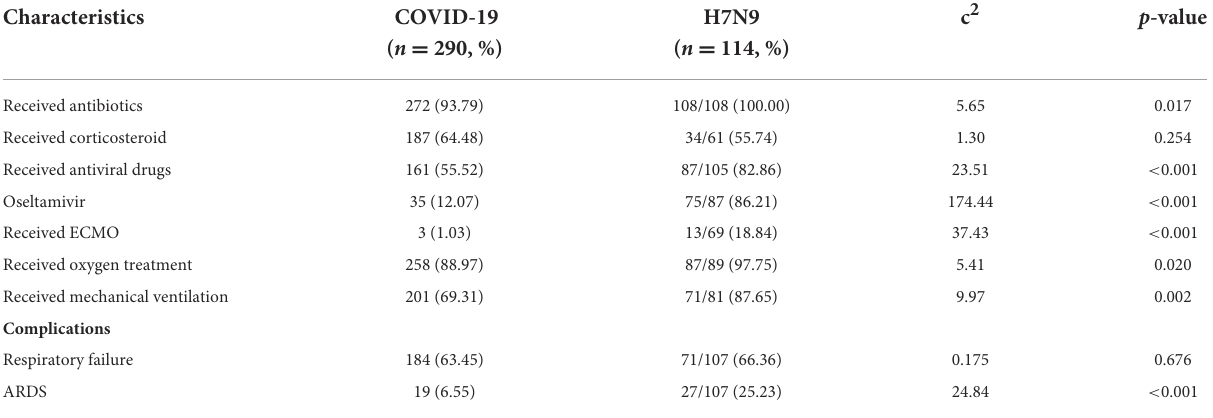
TABLE 2 Treatment and complications in fatal cases with COVID-19 and H7N9.